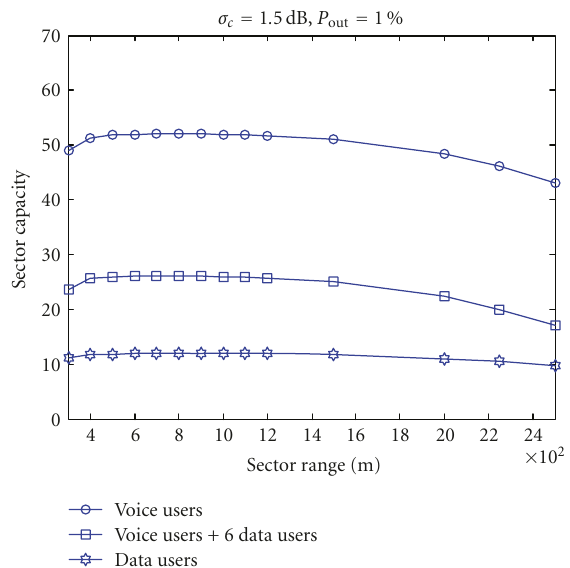
Figure 6: Outage probability of the sector for mixed voice and data users.